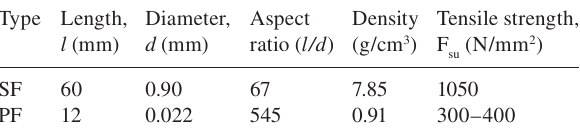
Table 3 Properties of fi